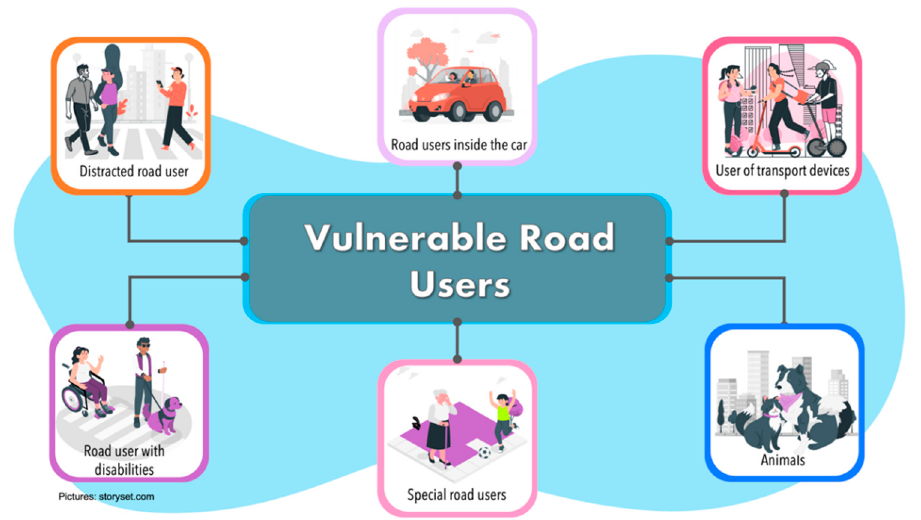
Figure 4. Representation of the different categories for VRUs.